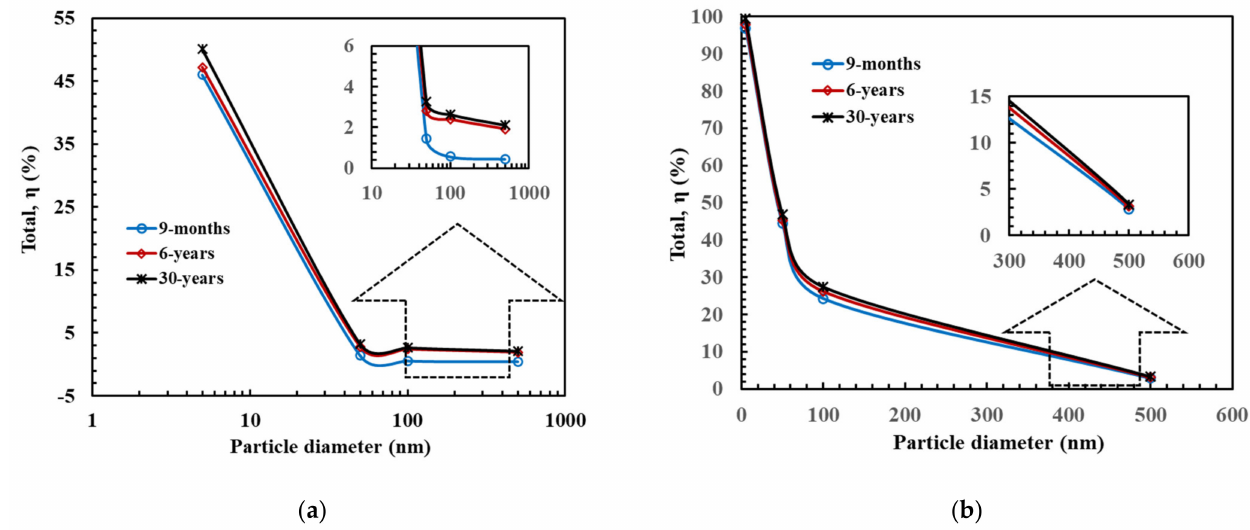
Figure 8. Particle deposition efficiencies of the lung are defined in Figure 1. ( a ) Upper airways (G0–G3) and ( b ) lower airways